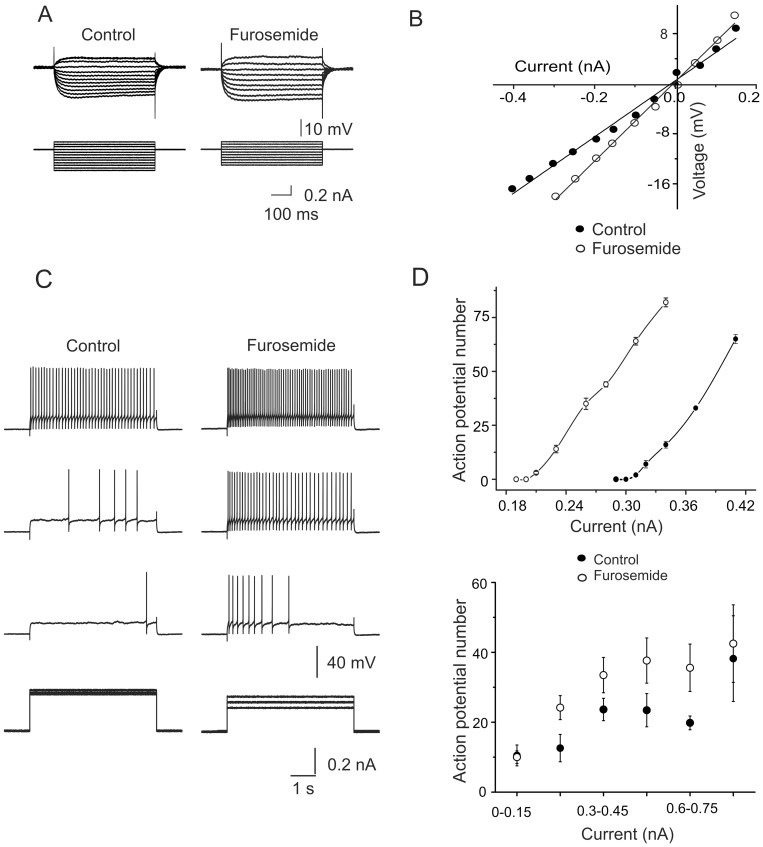
Furosemide-sensitive GABAA receptors modulate motoneuron excitability.A) Current-voltage responses recorded intracellularly from one motoneuron in control Ringer and in the presence of furosemide (200 µM). B) Current-voltage plot from responses obtained as in A. Input resistance was 39 and 83 MΩ in control Ringer and in the presence of furosemide, respectively. C) Action potential firing at different depolarizing intracellular current pulses recorded intracellularly in control Ringer and in the presence of furosemide (200 µM). D) Plot of the depolarizing current pulses versus the number of APs evoked in one cell (upper panel) and a group of cells (lower panel) in control Ringer and in the presence of furosemide.